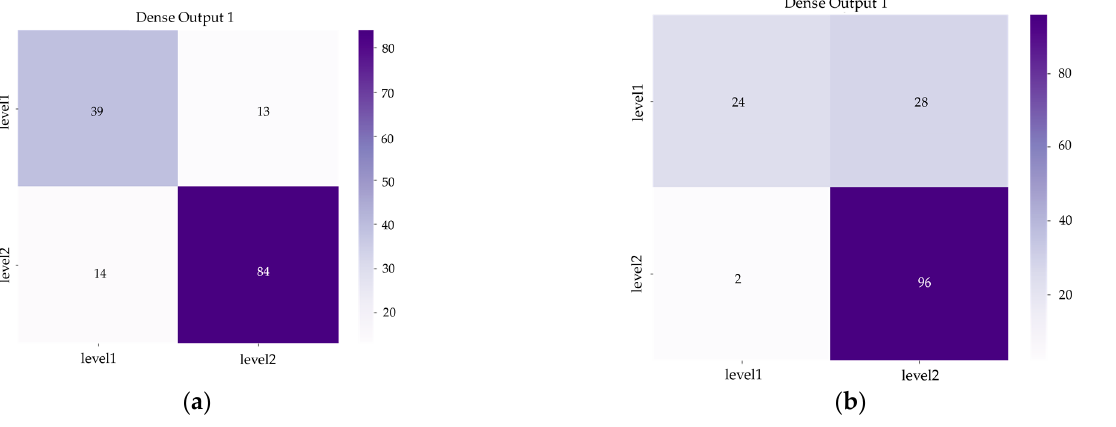
Figure 8. Confusion matrix of ( a ) DenseNet and ( b ) Hybrid EfficientNet-DOLG on the COVID-19 severity assessment task. Darker colors illustrate larger number of the correct predicted labels.